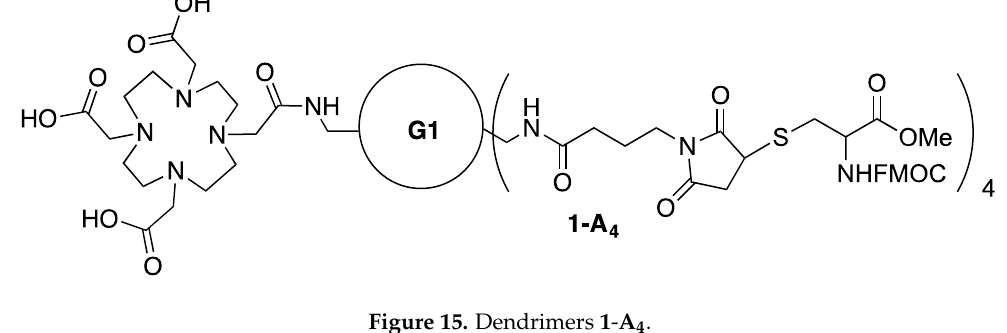
Figure 15. Dendrimers 1 - A 4 Figure 13. Dendrimers 1 - A 4 .